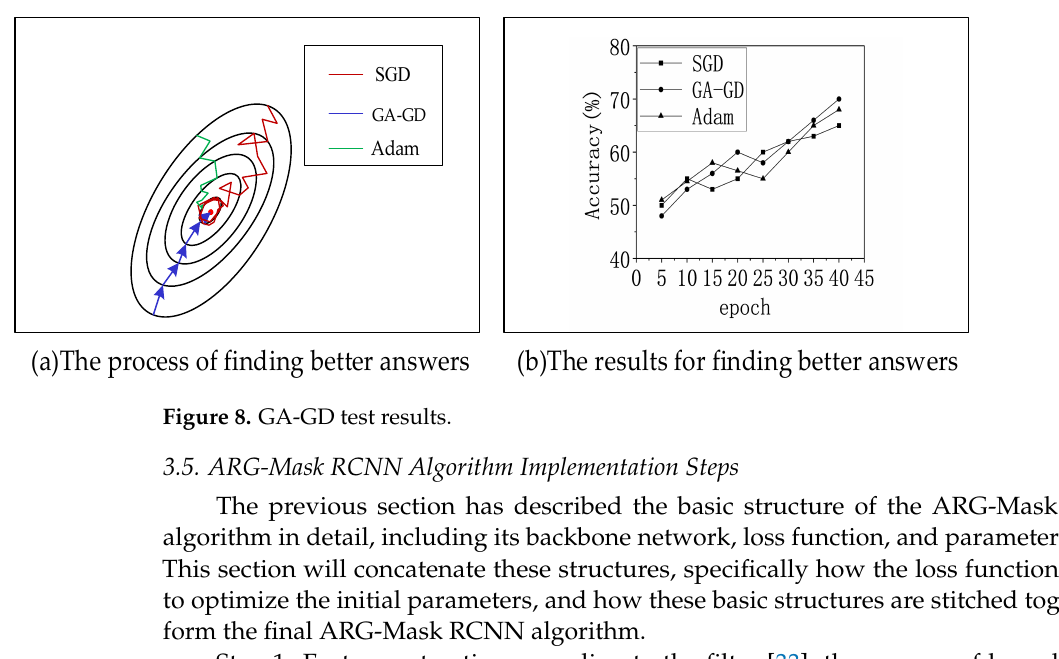
Figure 7. GA-CNN implementation flowchart.